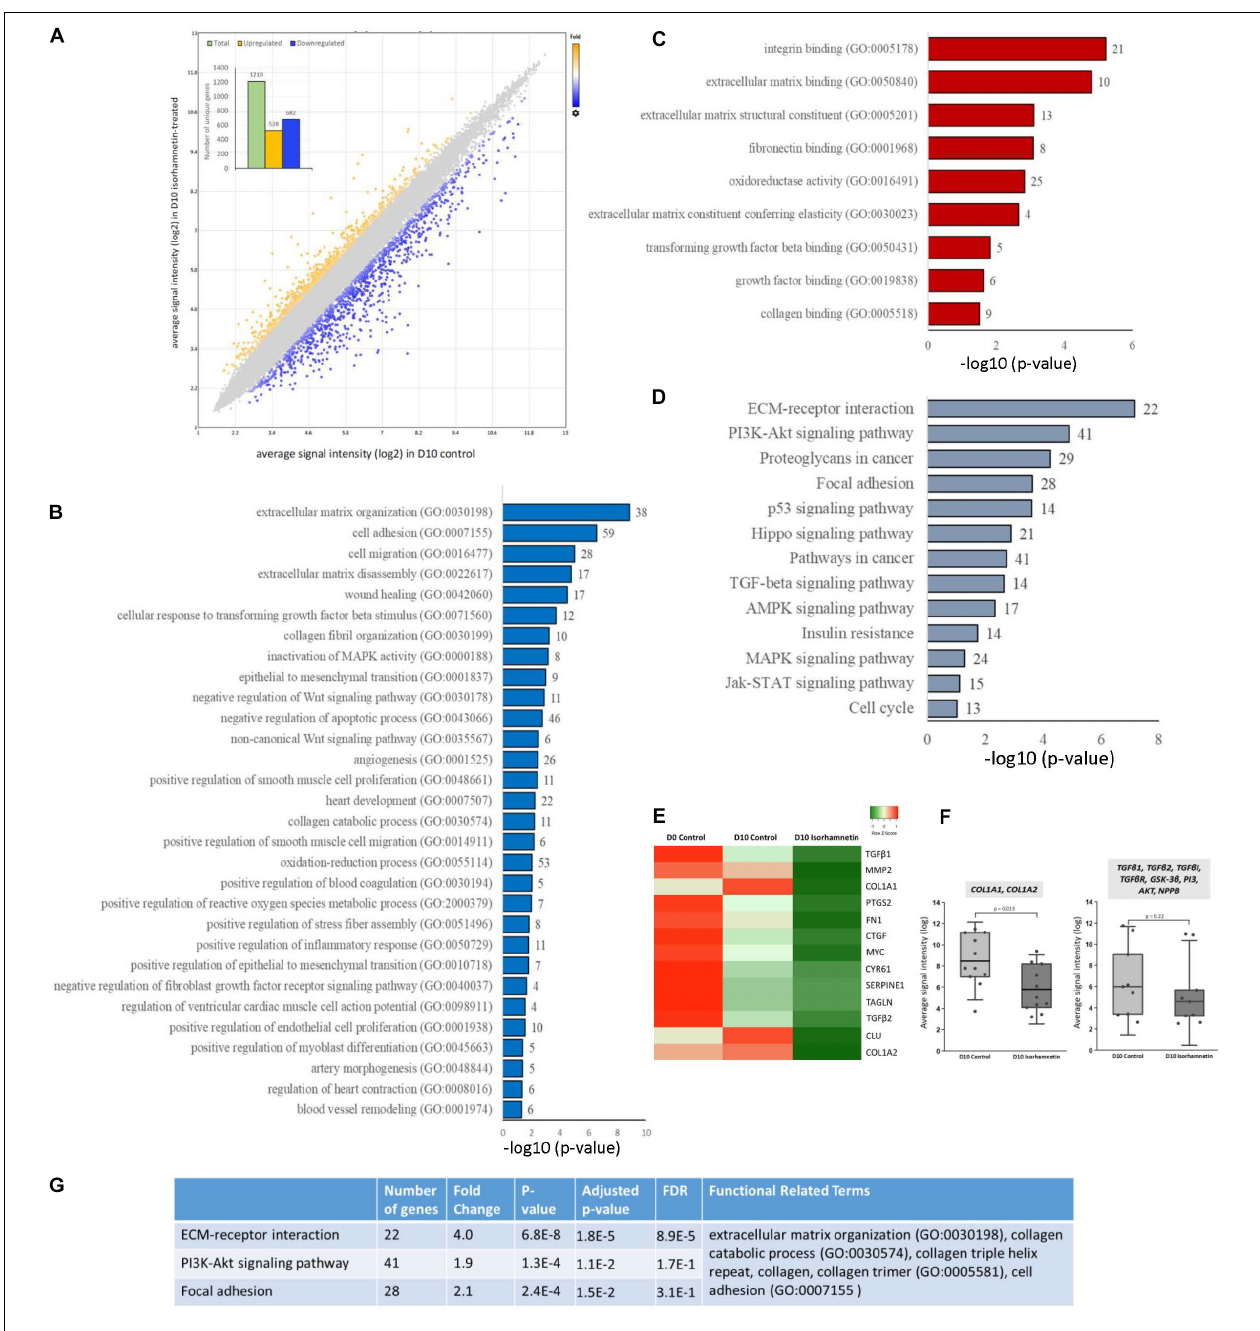
FIGURE 1 | (A) Scatter plot showing the distribution of DEGs by fold changes. The X -axis corresponds to the average signal intensity (log2) of each probe ID in D10 control hAESCs, and the Y -axis corresponds to the average signal intensity (log2) of each probe ID in D10 Isorhamnetin-treated hAESCs. Blue dots represent the significantly downregulated and yellow dots represent the significantly upregulated DEGs (DEGs, differentially expressed genes with fold change > 1.5; p < 0.05, one-way between-subjects ANOVA). The inset column graph shows the number of upregulated and downregulated DEGs (unique gene). Bar graphs showing the significantly enriched ( p < 0.05; modified Fisher’s exact test) (B) biological processes, (C) molecular functions, and (D) KEGG pathways by the DEGs between D10 isorhamnetin-treated and D10 control hAESCs. The X -axis corresponds to the –log10 p -value. The number of DEGs is presented at the outer end of each bar. (E) Heatmap showing the expression intensity of selected cardiac fibrosis-associated genes. Heatmap was generated using an online tool Heatmapper (http://www.heatmapper.ca/). (F) Boxplots showing the comparison of expression intensity of all probe IDs of selected genes between D10 control and D10 isorhamnetin-treated hAESCs. Box ranges from 25th to 75th percentile, the line in the middle represents the median value, and the error bar represents the standard deviation (SD). Significance was computed by t -test for linear distributions and Mann-Whitney U test for non-linear distributions. (G) Table showing the most significantly enriched annotation cluster computed for KEGG pathways and biological processes. The enrichment score for this fibrosis-associated cluster was 4.89 (measurement criteria: Similarity threshold = 0.5, multiple linkage threshold = 0.5, and enrichment thresholds = 1.0).